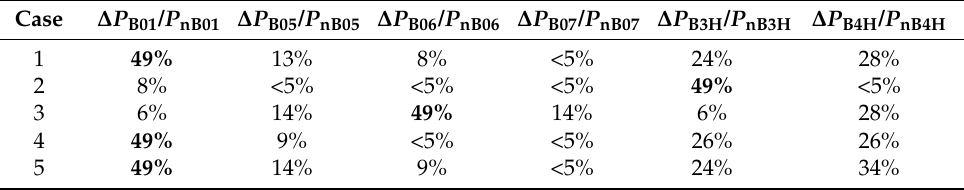
Table 8. List of sources with percentage values of power surges in considered cases.